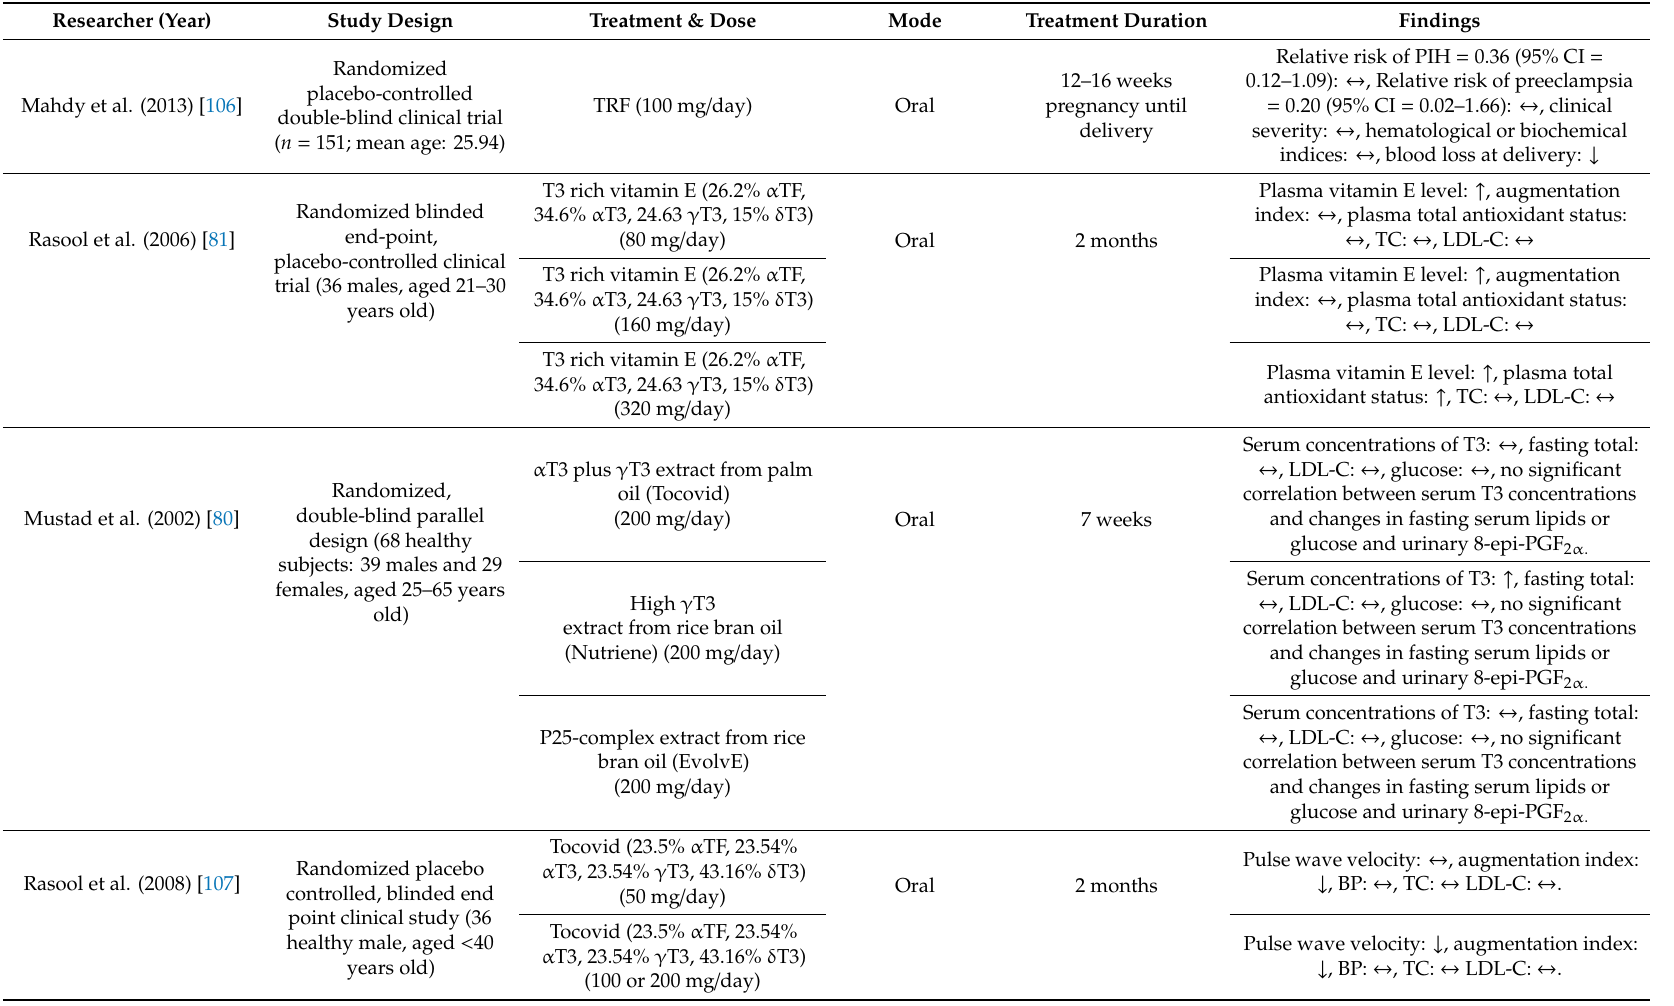
Table 5. E ff ects of T3 on CVD in